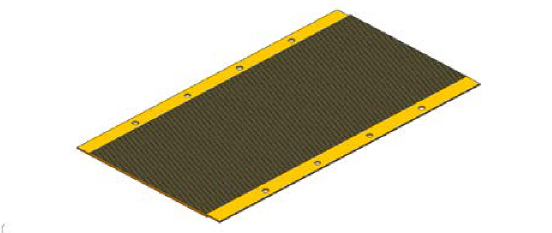
Fig. 2. Bottom laying module structure